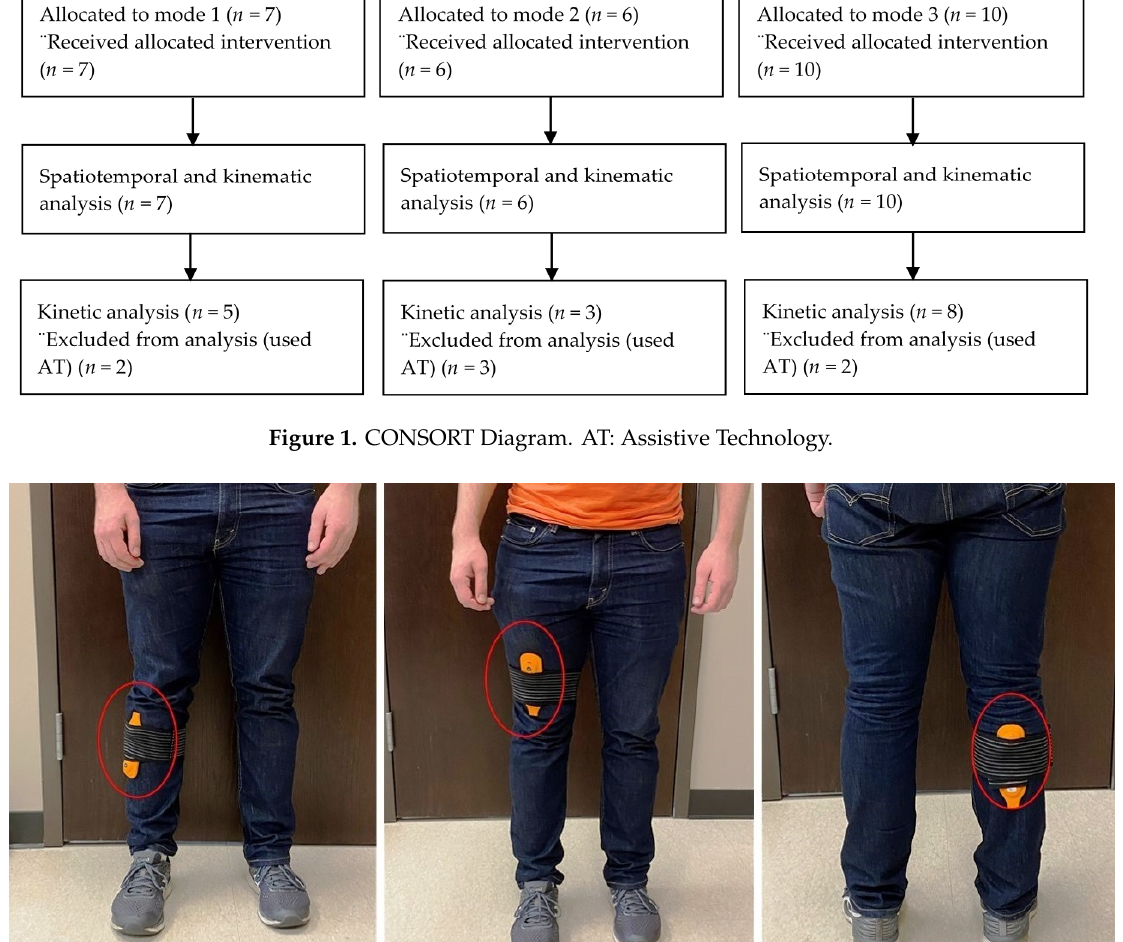
Figure 2. Attachment of MyoVolt™ focal muscle vibration device. ( a ): device attached using a strap to the right anterior tibialis muscle. ( b ): device attached using a strap to the right quadricep muscle. ( c ): device attached using a strap to the right gastrocnemius muscle.